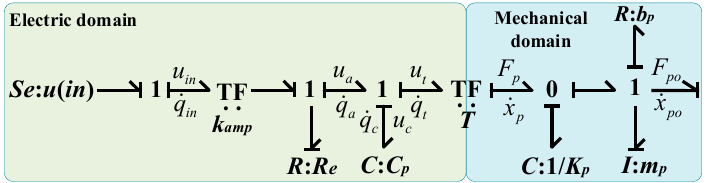
Figure 3. Bond graph model of the piezoelectric actuator.